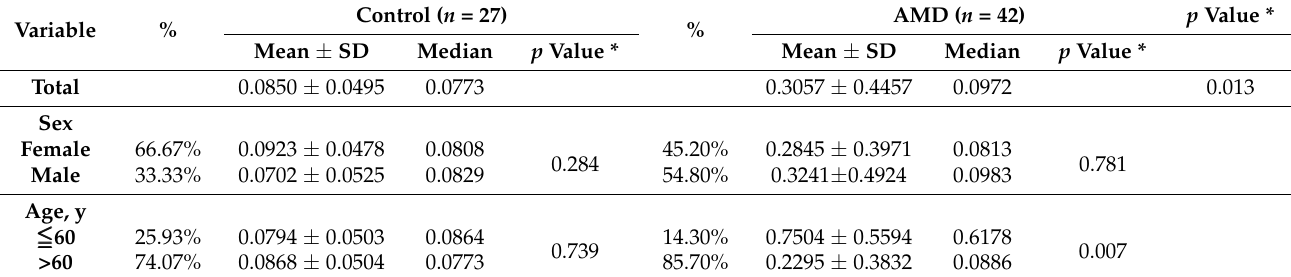
Table 2. Comparison of GABARAPL1 expression between age-related macular degeneration and normal control.